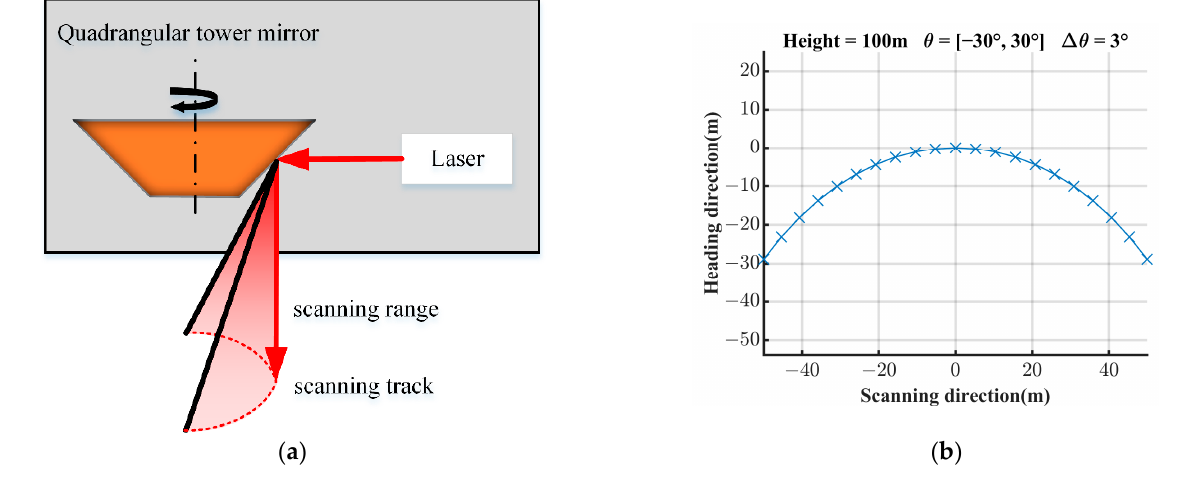
Figure 6. Quadrangular tower mirror scanning mode 1. ( a ) Scanning schematic diagram; ( b ) Scanning track with a height of 100 m, a motor rotation angle of ± 30 ◦ and an interval angle of 3 ◦ between points.